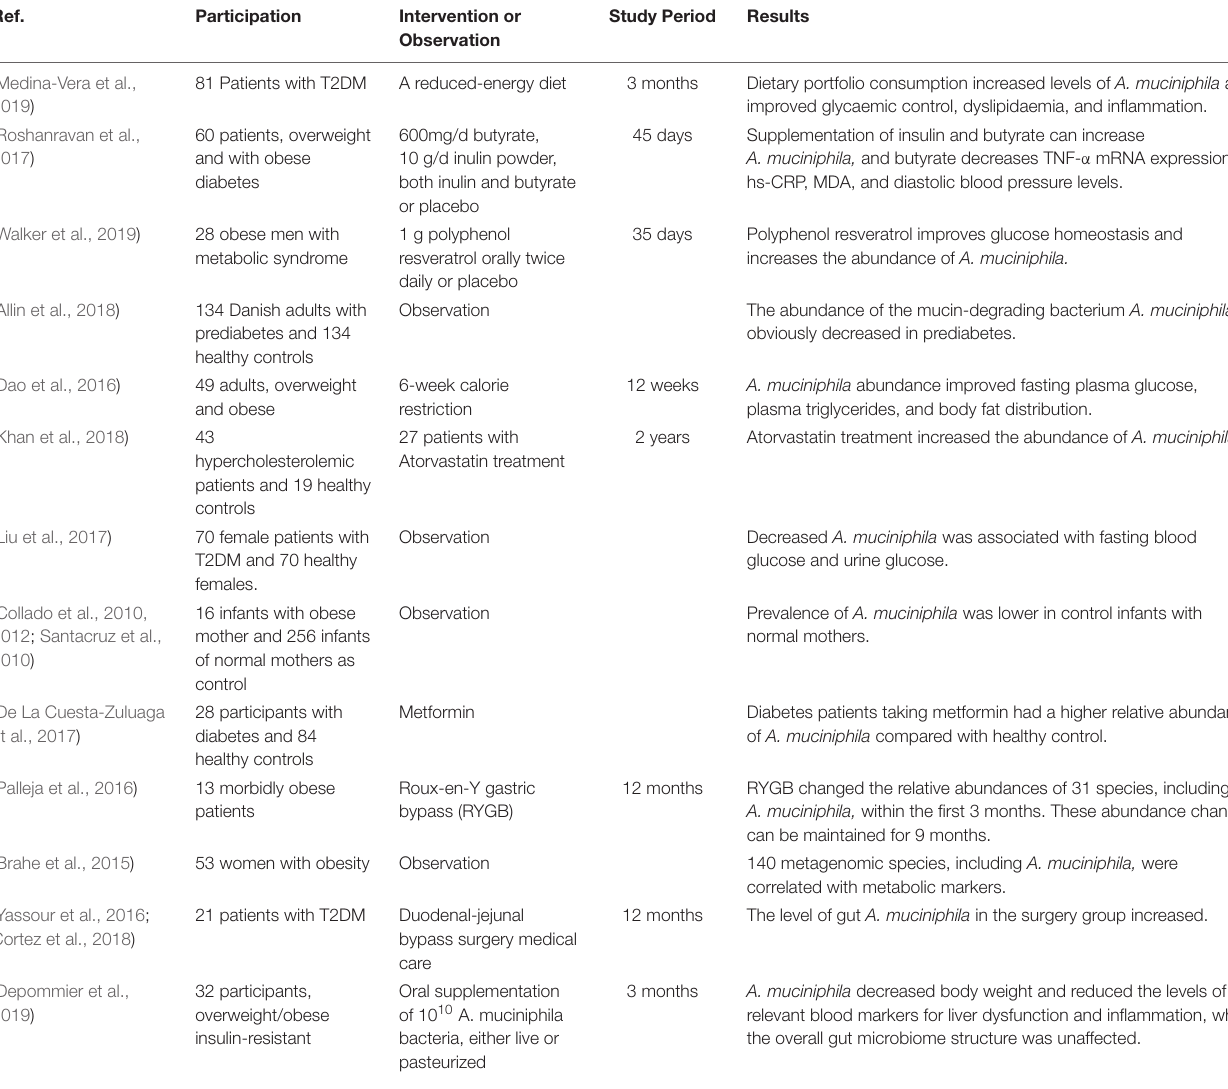
TABLE 1 | Overview of A. muciniphila and its associated biomarkers in clinical studies of obesity.